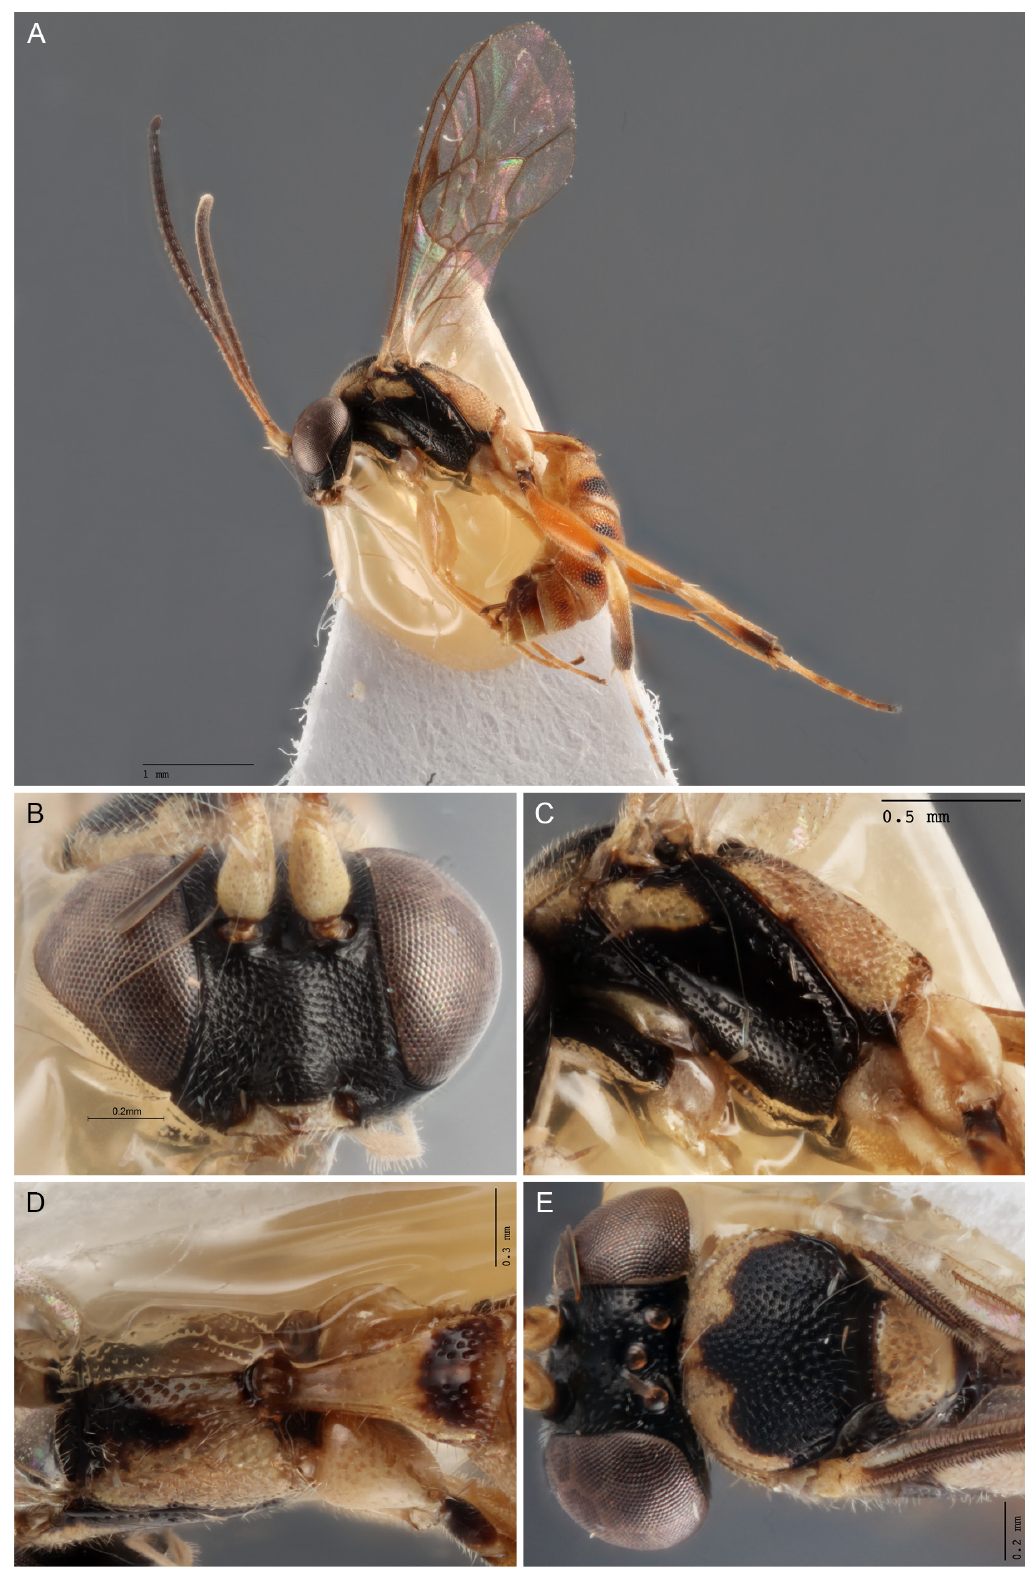
Fig. 22. Palpostilpnus angkor sp. nov., holotype, ♀ (RBINS). A . Lateral habitus. B . Head, anterior view. C . Mesopleuron. D . Propodeum and T1, dorsal view. E .